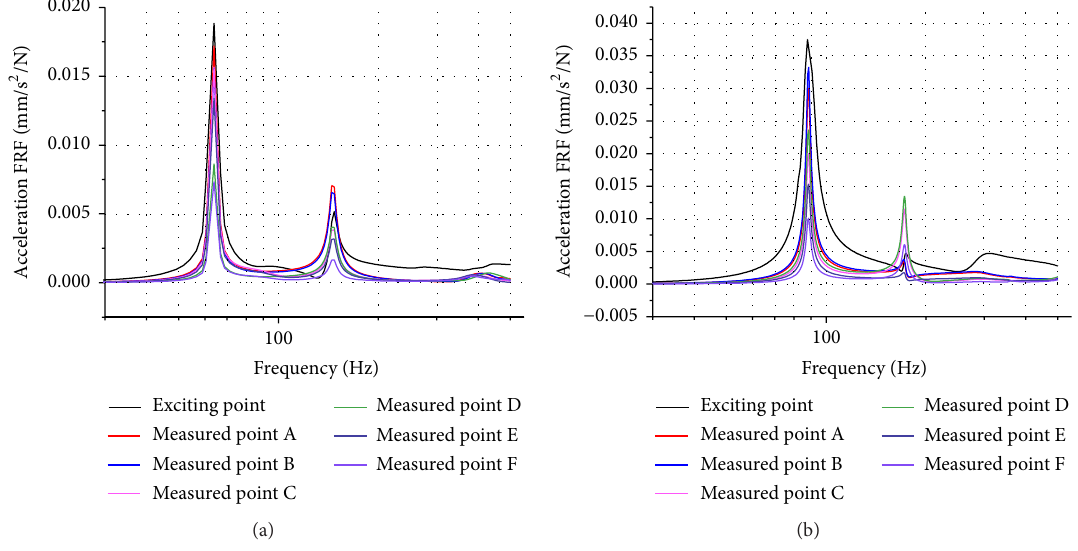
Figure 29: Acceleration FRF of the FE models: (a) the control base and (b) the verification